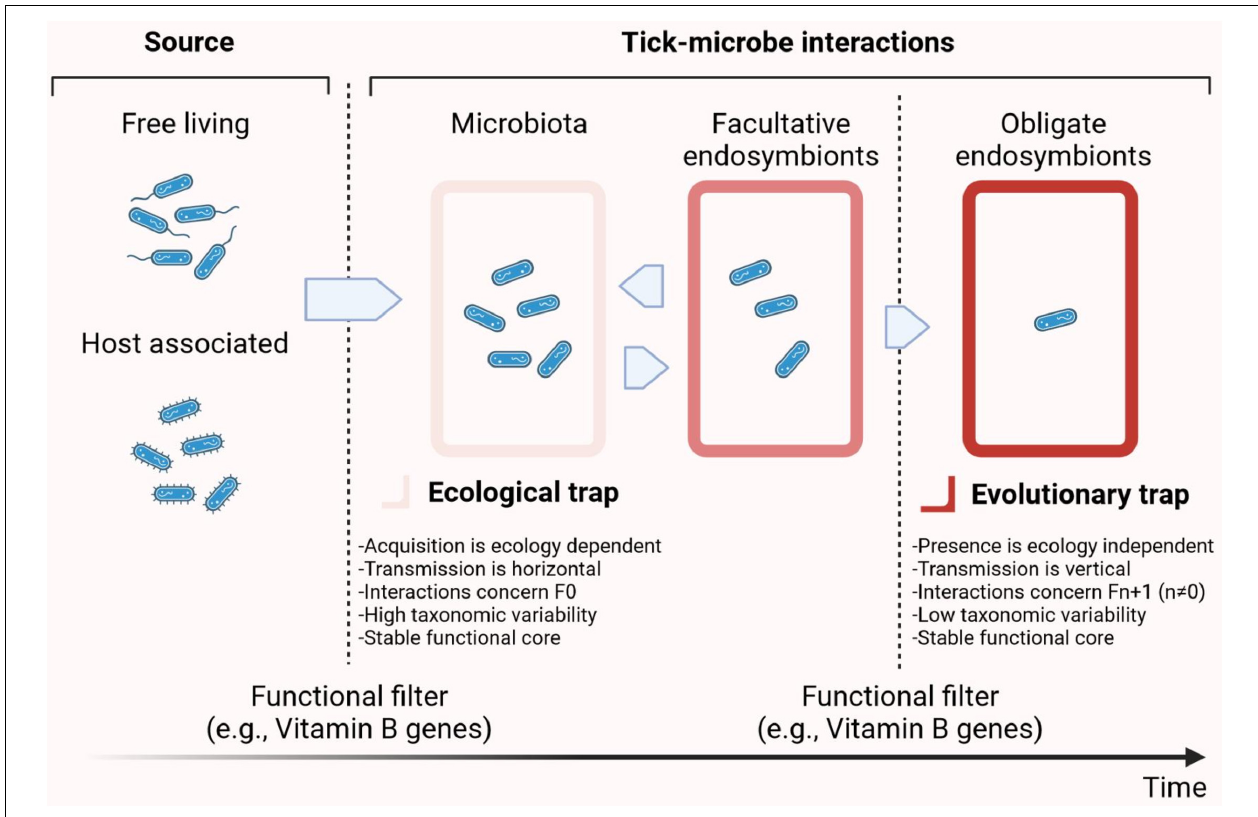
FIGURE 1 | Symbiotic continuum in